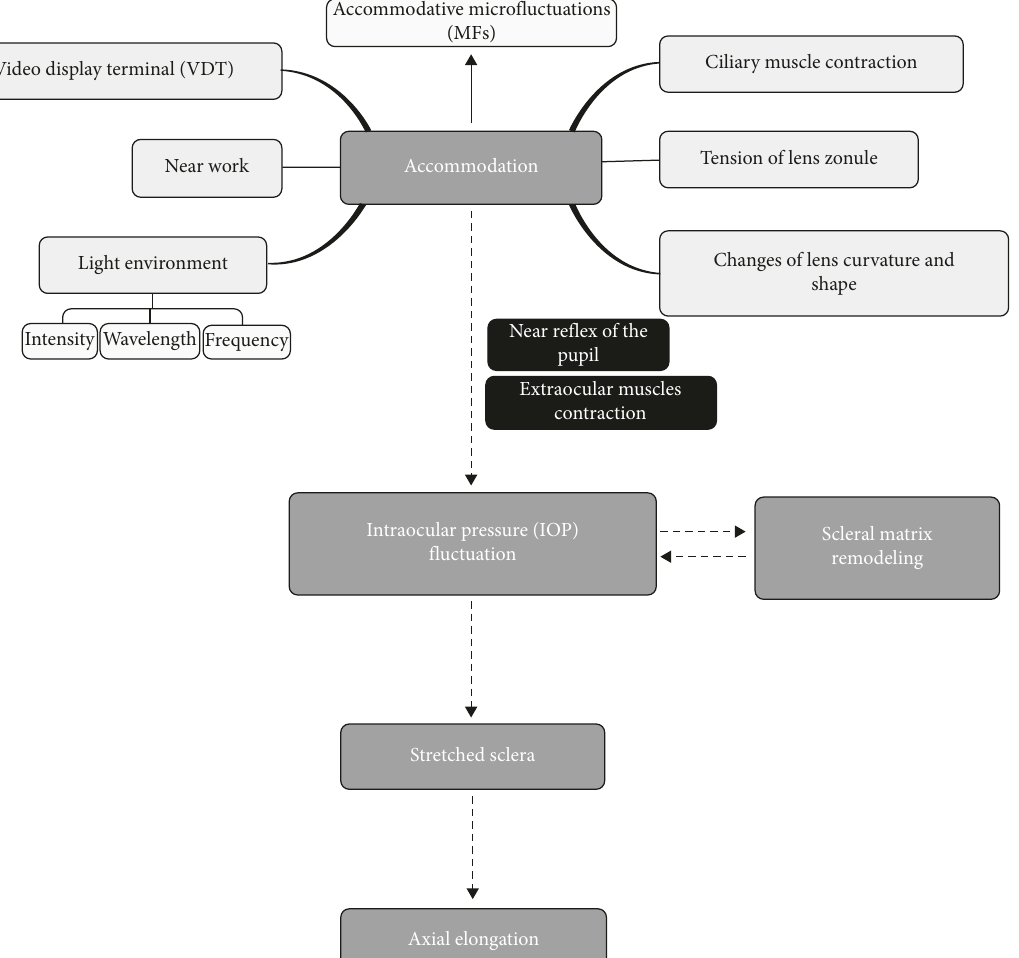
Figure 1: Overall framework of the hypothesis regarding accommodation-induced IOP fluctuations in myopia. Table 1: Accommodation-induced elongation of axial length in different refractive status. Ref.